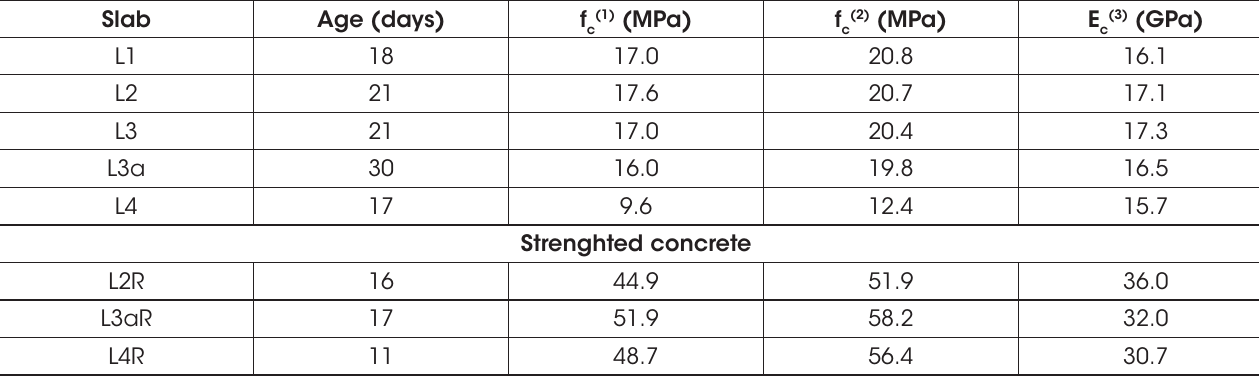
Mechanical properties of concrete used for all slabs